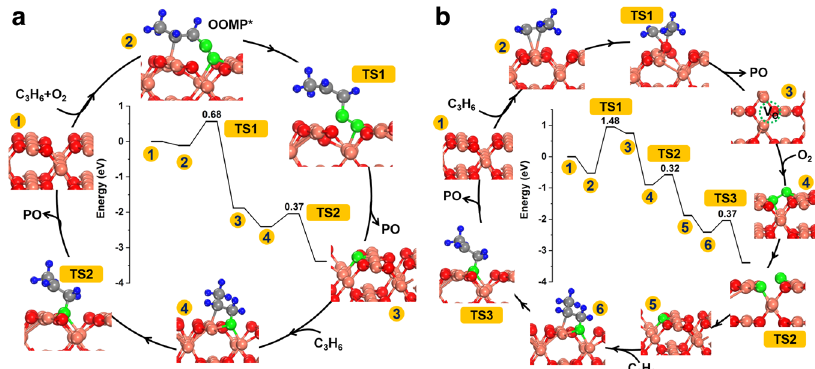
Fig. 4 DFT calculations. Energy pro fi le and catalytic cycle along with the optimized structures of intermediates and transition states for propylene epoxidation on Cu 2 O(110) via a LH and b MvK mechanisms. The pink, red, green, gray, and blue spheres represent Cu, O in Cu 2 O, O in O 2 , C, and H